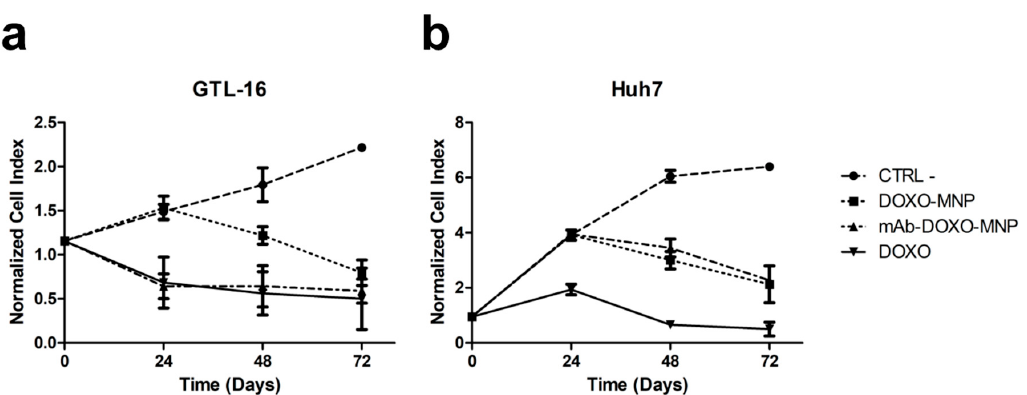
Figure 10. Cytotoxicity of mAb-DOXO-functionalized nanoparticles. Real-time toxicity of the not functionalized MNPs, of the MNPs functionalized only with DOXO, or only the mAb or with both DOXO and mAb were performed on the Met/HGF-R+ GTL-16 and on the Met/HGF-R- Huh7 cells. The presence of the DO-24 mAbs significantly increase the toxic activity of the DOXO-functionalized MNPs on GTL-16 cells ( a ), whereas it had no effect on Huh7 cells ( b ). Cell index, indicative of cell viability, was measured in a xCELLigence ® assay. CTRL − , control untreated cells. Incubation with not functionalized MNPs gave results similar to those of the control untreated cells.